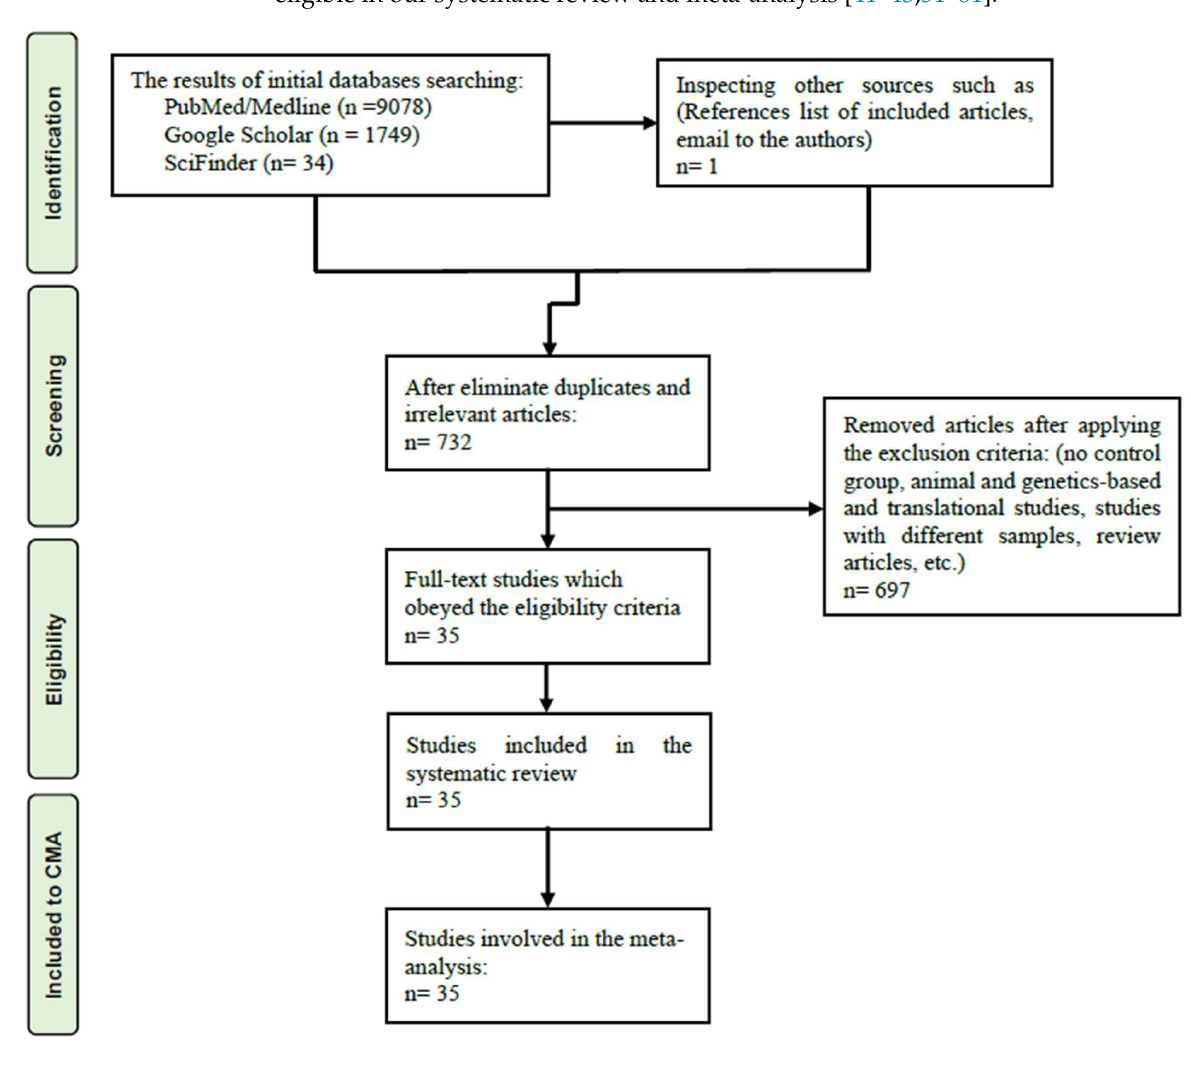
Figure 2. The PRISMA flow chart.